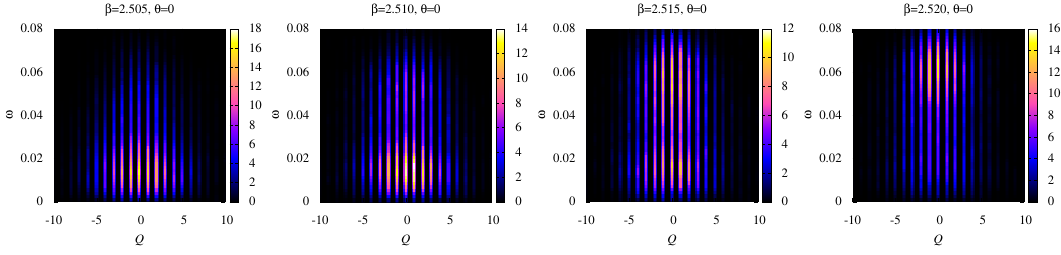
Figure 5 . Two dimensional histograms on the Q - ω plane at four values of β